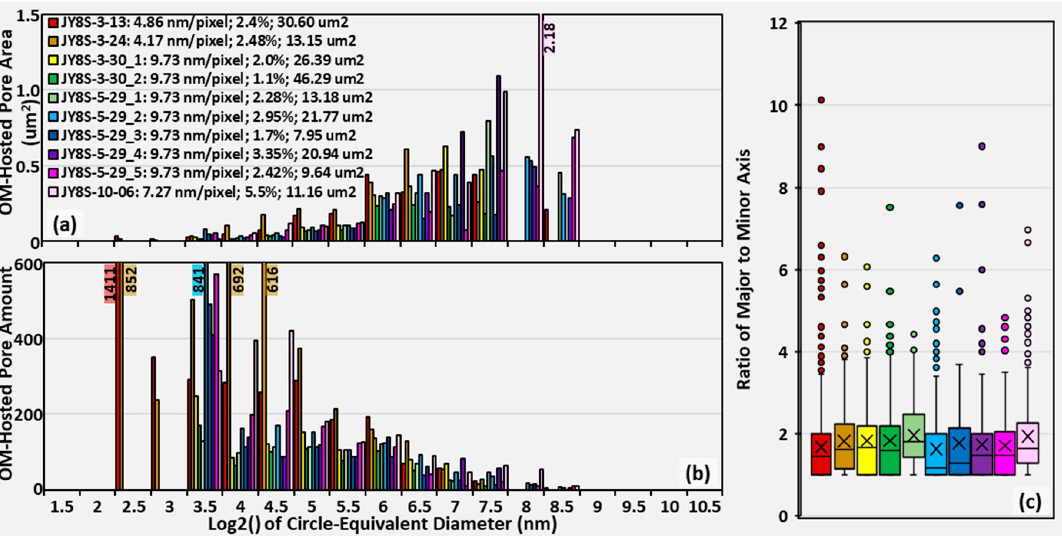
Figure 13. The pore size distribution (PSD) and geometry of OM-hosted pores within the second subtype of weakly or undeformed porous pyrobitumen (OM V) of Longmaxi-Wufeng Shale, Eastern Sichuan Basin. ( a ) PSD determined by pore sectional area; ( b ) PSD determined by pore amount; and ( c ) ratio of major to minor axis. The three values after image ID in the legend are image resolution (nm/pixel), organic porosity (%), and OM sectional area (µm 2 ). The number labels show the values that are beyond the range of the vertical axis.